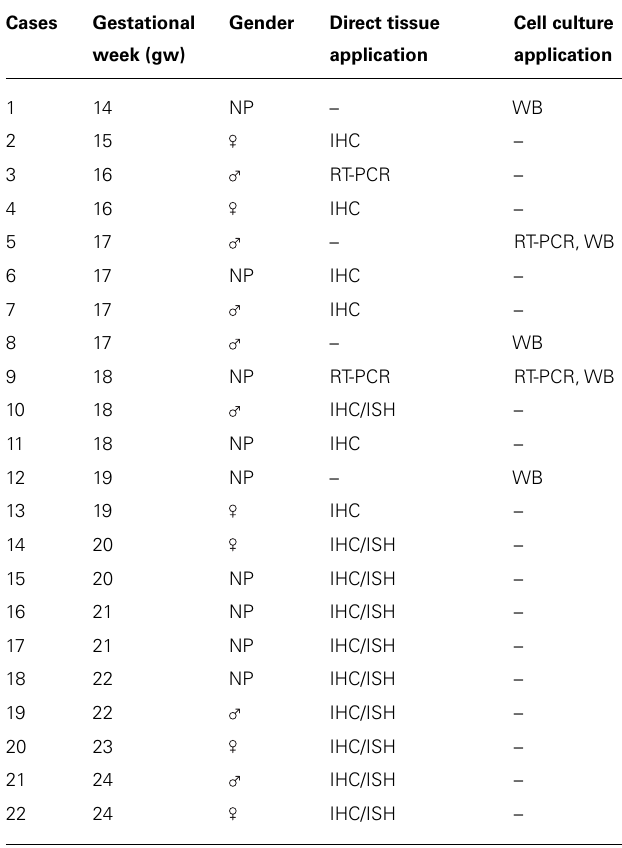
Table 1 | Fetal human brain tissues analyzed in the